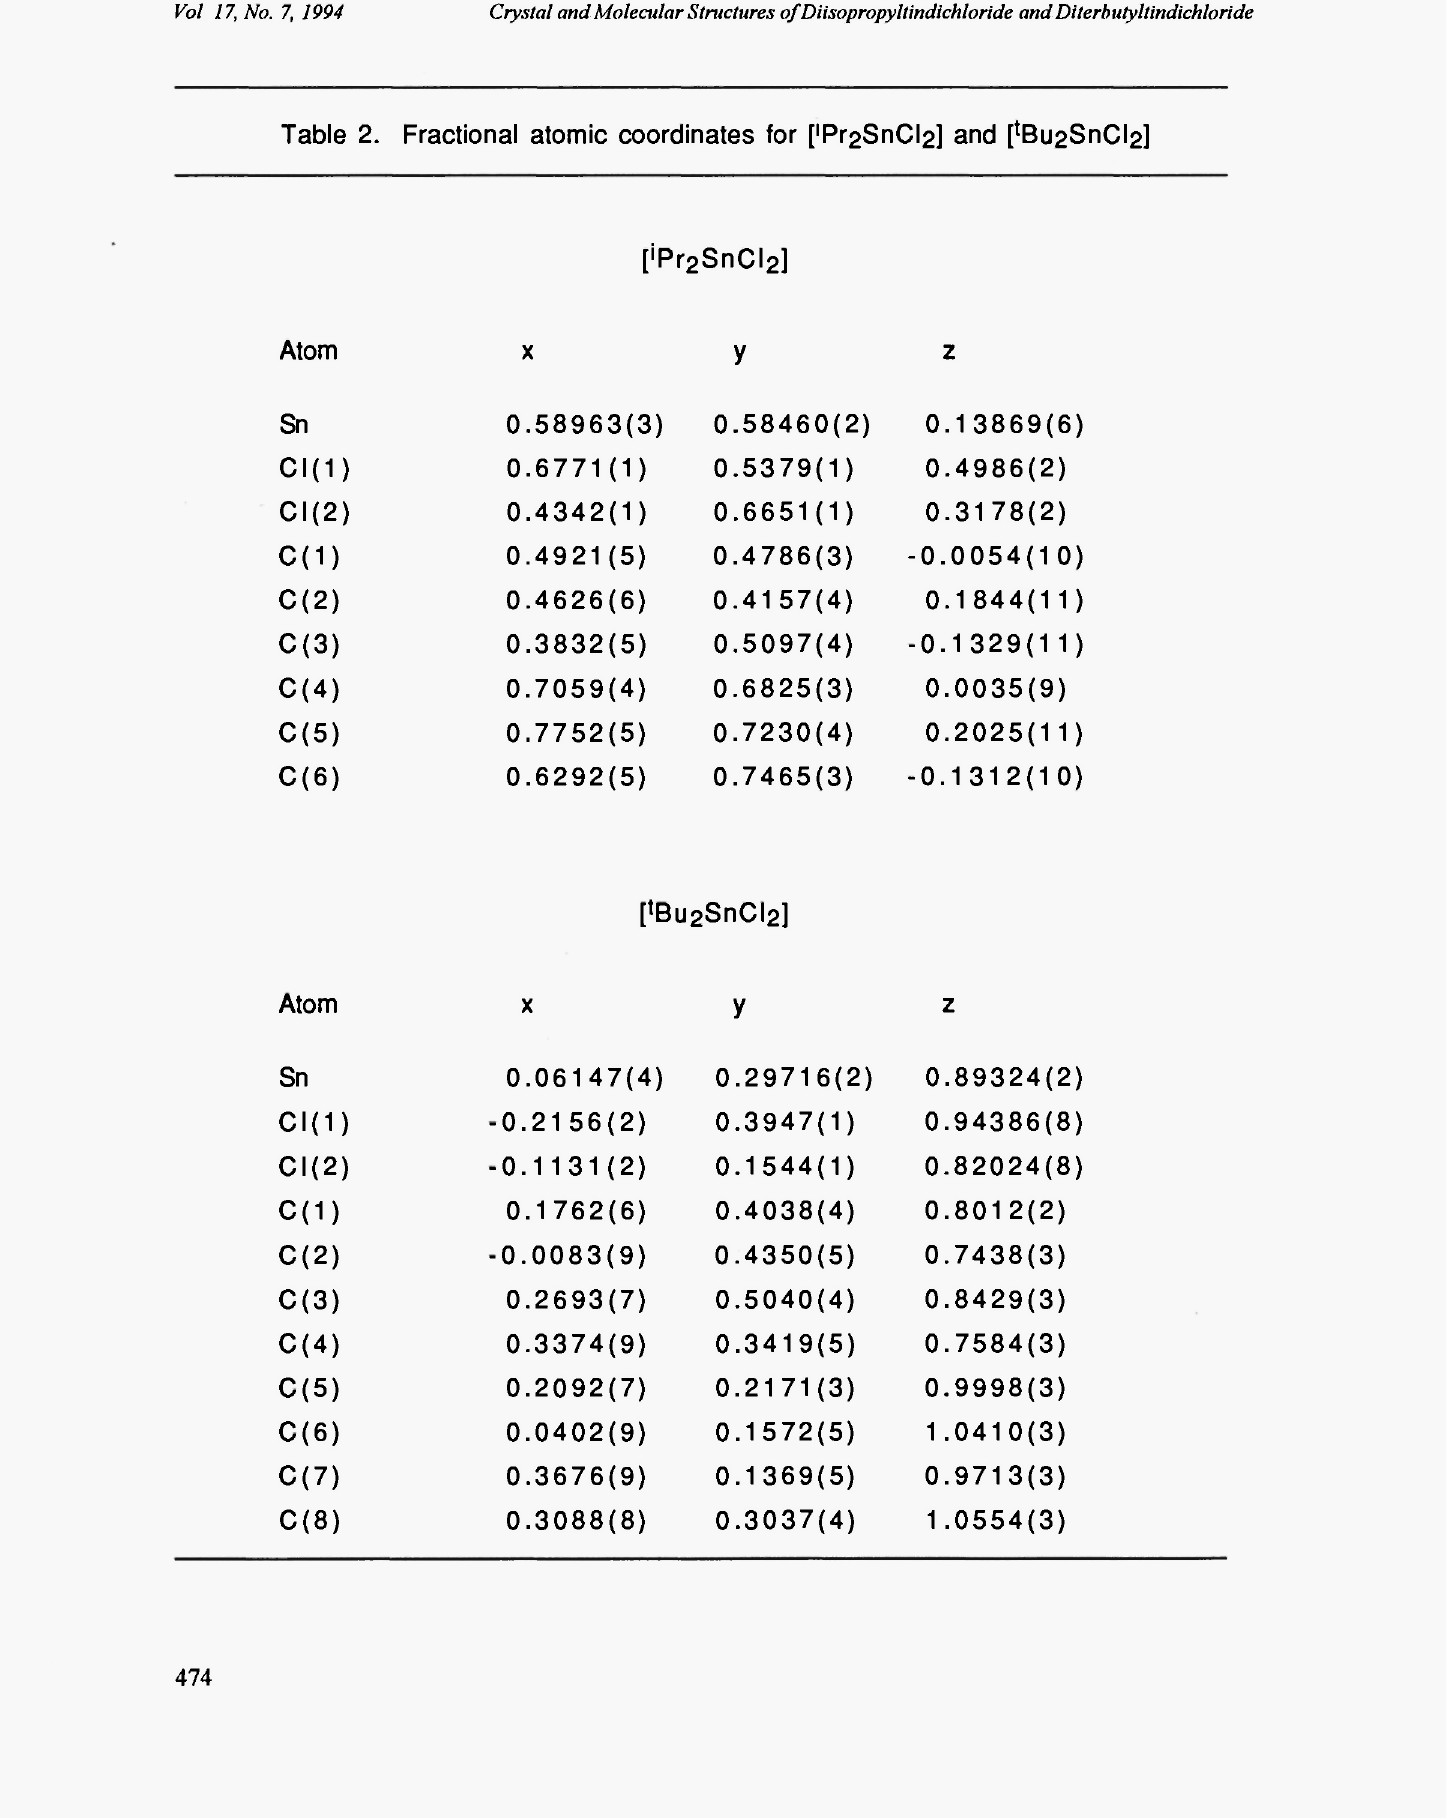
Table 2. Fractional atomic coordinates for ['Pr2SnCl2] and [ l